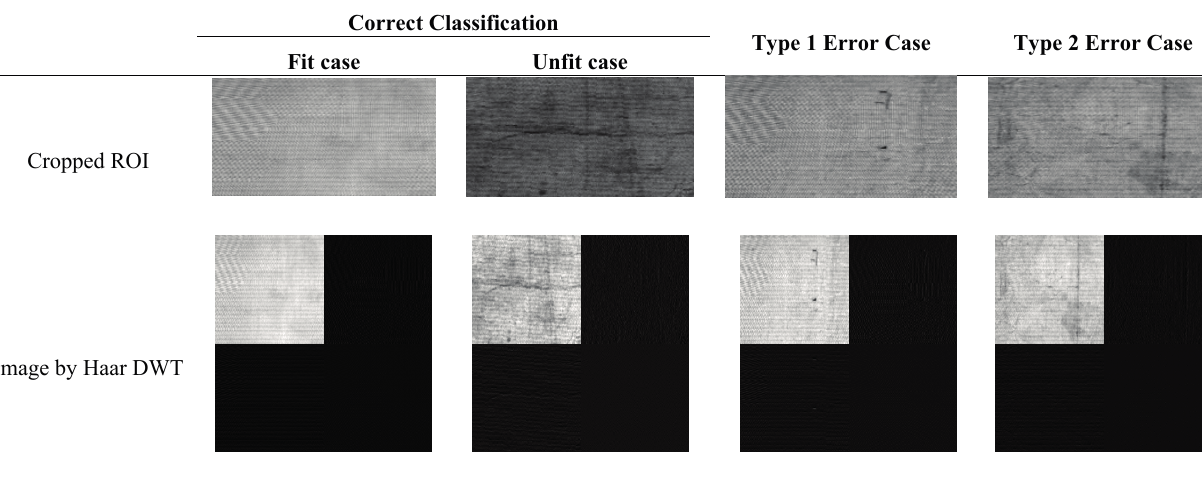
Table 6. Cases of correct classification, type 1 errors, and type 2 errors in experiments on a 50-Rupee banknote (A-direction) using Haar